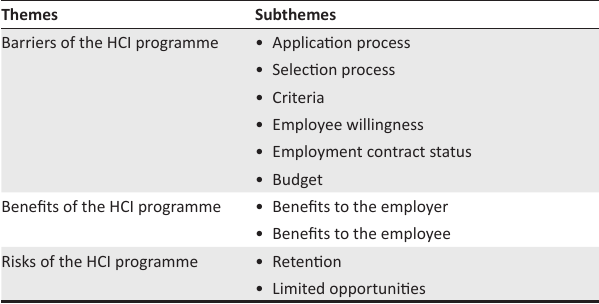
TABLE 1: Themes and